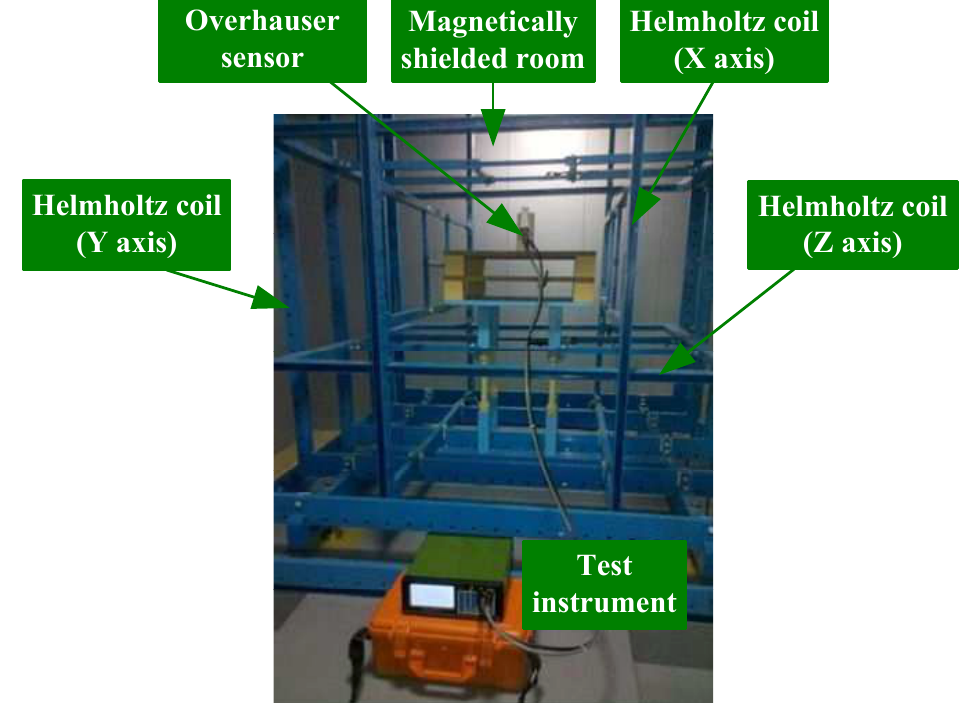
Figure 13. Artificial magnetic field-generating space.